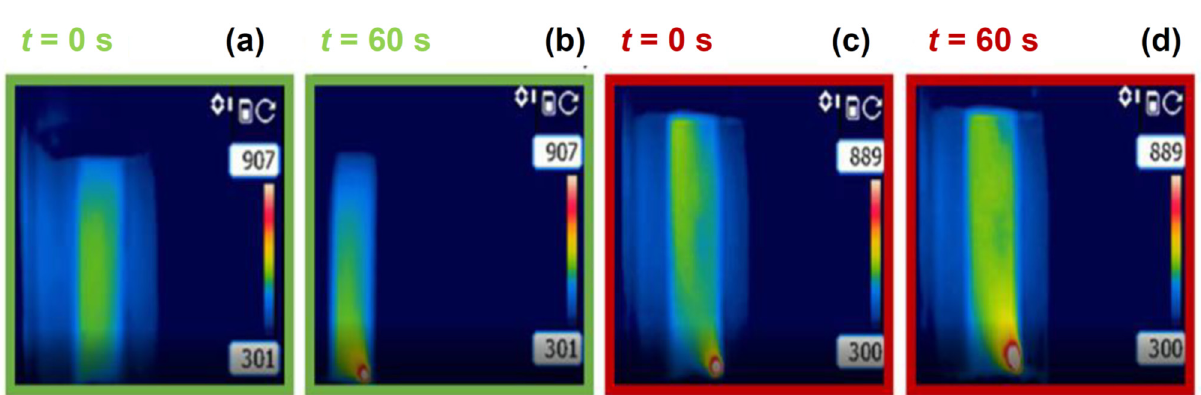
Figure 8. Thermal camera images of the ( a , b ) Ag- and ( c , d ) Pt-plated samples treated with 2 mA mm − 2 . The electric current is applied at t = 0 s. Top of the sample = cathodic region ( − ); Bottom of the sample = anodic region (+).